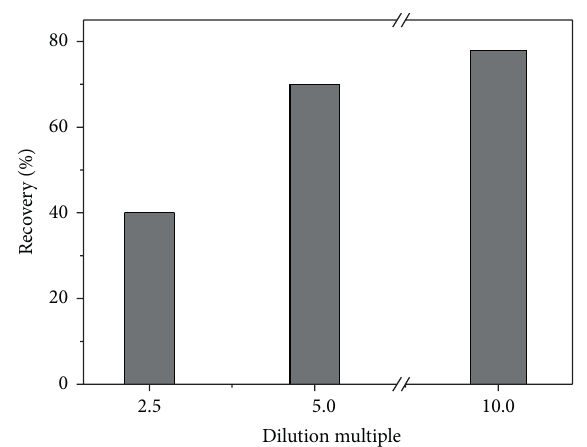
Figure 7: Recoveries of SMR from calf serum treated by C 8